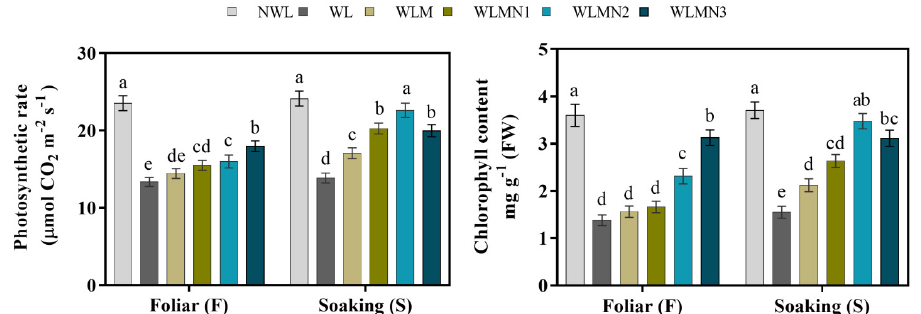
Figure 2. The photosynthetic rate and chlorophyll content of maize seedlings under waterlogging stress conditions. Data are presented as mean ± SD ( n = 3, biological replicates). Different small let- ters (a,b,c,d,e) in each column indicate significant differences at p ≤ 0.05 (least significant difference (LSD) test). The abbreviations of treatment names are the same as those described in Table 2. 3.4. Effect of Nitrate of on Antioxidant Enzymes Activities of Maize Seedlings Treated with Melatonin under Waterlogging Stress Conditions Waterlogging stress (WL) markedly reduced the antioxidant enzyme activity com- pared to NWL and WLM. However, melatonin with KNO 3 significantly improved antiox- idant enzyme activity in maize seedlings subjected to waterlogging stress compared to NWL and WLM (Figure 3). The application of melatonin with KNO 3 treatment showed the same pattern for improving the various antioxidant enzyme activities. However, com- pared with WL and the foliar spray of melatonin with KNO 3 treatment, WLMN2 signifi- cantly increased the SOD, POD, CAT and APX activities by 46.42%, 60.99%, 48.14% and 170.09% respectively, followed by WLMN3. Seed soaking treatment WLMN2 enhanced the antioxidant enzymes activity of the SOD by 56.87%, POD by 86.33%, CAT by 51.94% and APX by 124.51%, compared with WL. The overall results demonstrated that foliar treatments WLMN2 and WLMN3 were statistically similar in all antioxidant enzymes. In the seed soaking treatments, WLMN2 and WLMN3 showed statistically similar results for the CAT and APX activities of maize seedlings under waterlogging stress conditions (Fig- ure 3).